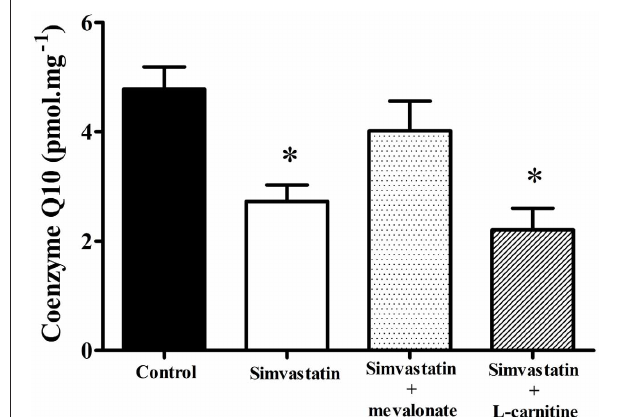
FIGURE 4 | Increase in lactate production by 1 µ M simvastatin was prevented by mevalonate, Co-Q10 or L-carnitine in skeletal muscle. An aliquot of MiR05 medium containing non-permeabilized skeletal muscle samples pre incubated by 1h with 1 μ M simvastatin or DMSO, or coincubated with 100 μ M mevalonate, 10 μ M coenzyme Q10 or 1mM L-carnitine was added to a medium containing 50mM hidroxilamine, 50mM tris, 800 μ M NAD + , 40U lactate dehydrogenase, pH 10 at 25 ◦ C, for spectrofluorimetric assay of lactate release. ∗ p < 0 . 05 vs. control by one-way analysis of variance. N = at least 5 independent experiments.